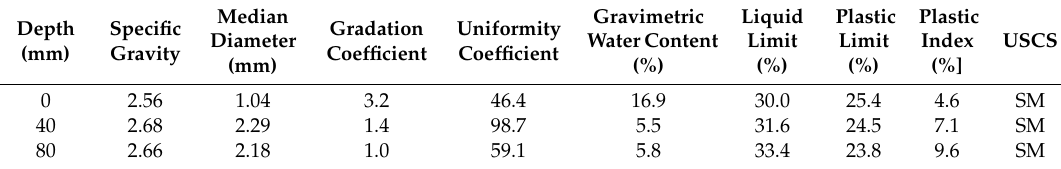
Table 1. Index properties of the soil samples with